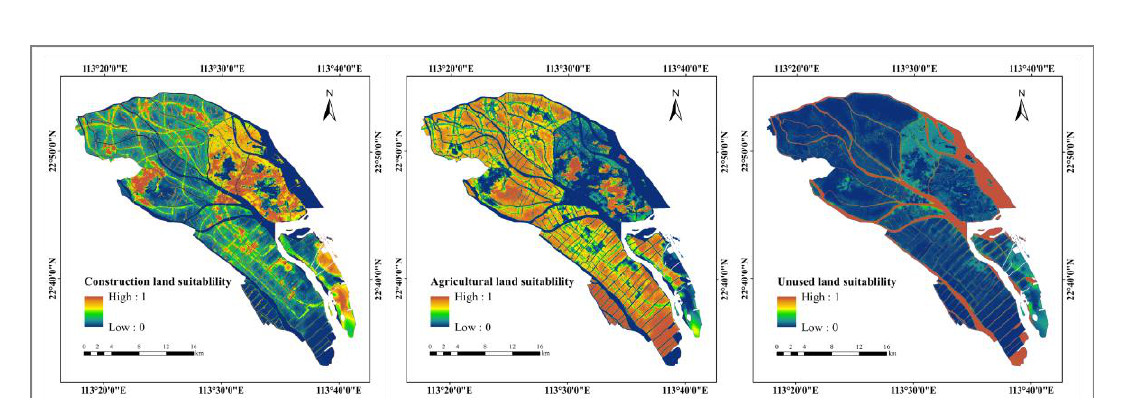
Figure 4. Spatial patterns of the suitability of construction land, agricultural land, and unused land in Nansha in 2019. Table 4. The meaning and data source of each driving factor in 2014, 2019, and 2020.